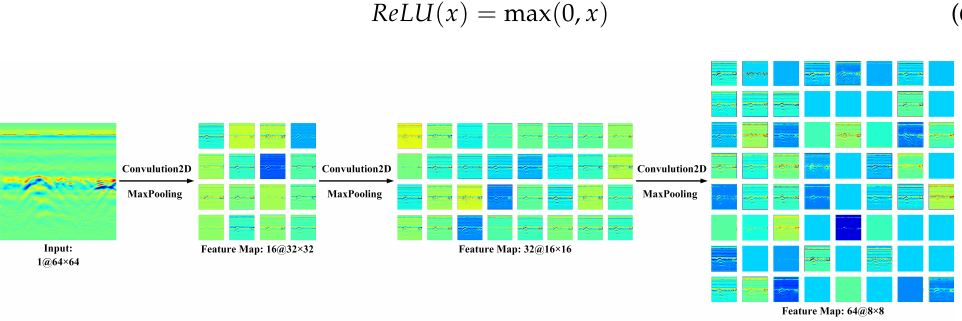
Figure 2. Feature maps of each